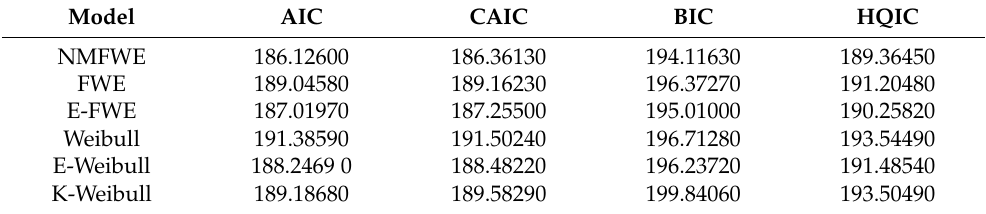
Table 5. The values of AIC, CAIC, BIC, and HQIC of the fitted models, using the first COVID-19 dataset.